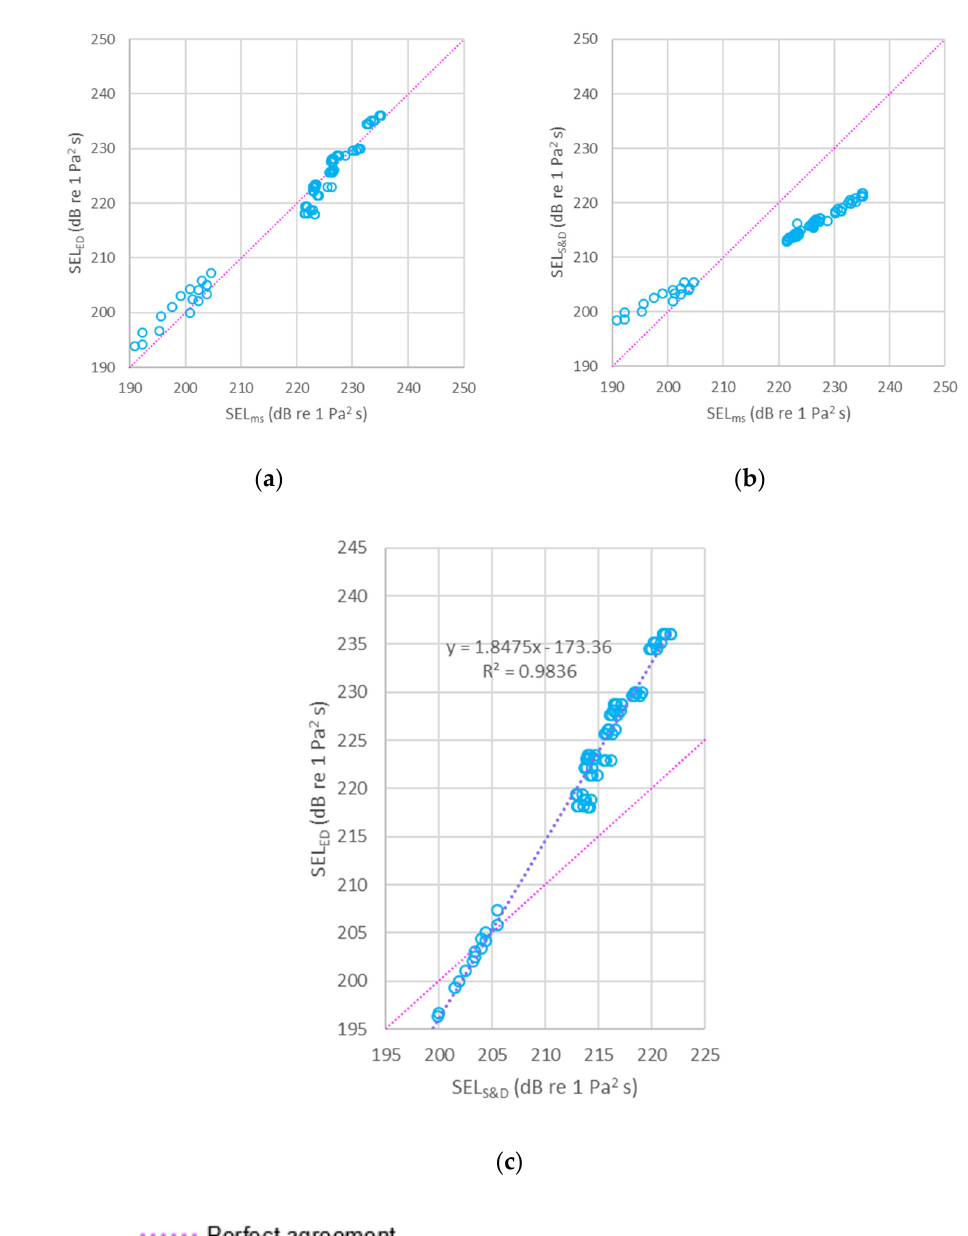
Figure 3. Comparison of simulated and measured values of SEL for open water blast data from TAP-025 [53] and TAP-570 [51], using EDGAR and Soloway and Dahl [66] models. ( a ) EDGAR-simulated values against measured values of SEL; ( b ) Soloway and Dahl [66]-simulated values against measured values of SEL; ( c ) EDGAR-simulated values against Soloway and Dahl [66]-simulated values of SEL.